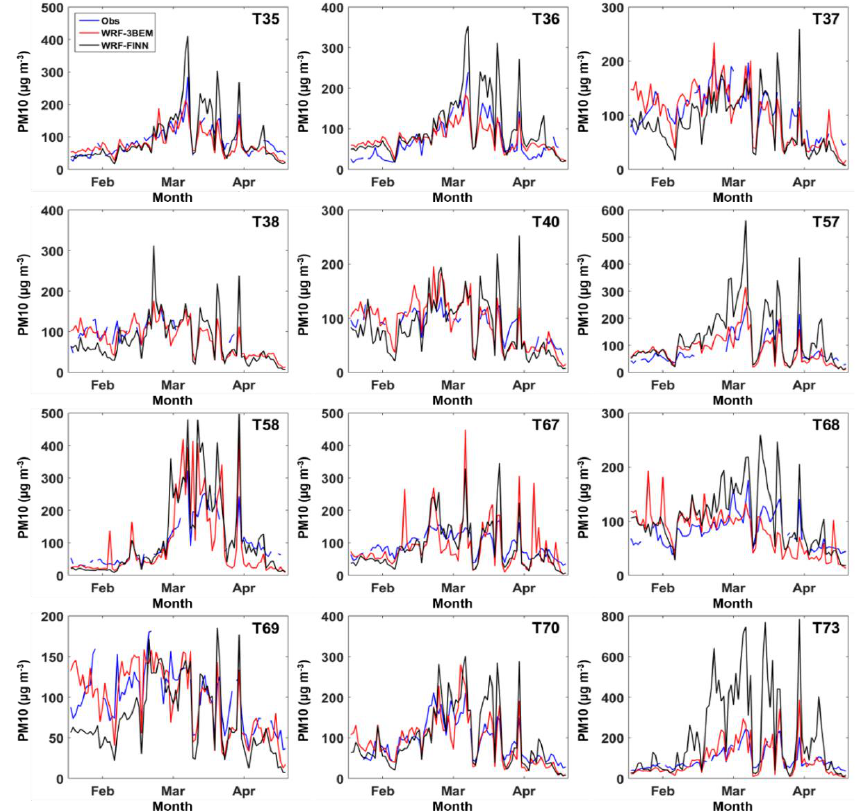
Figure 8. Comparisons of time series of measured daily average PM10 concentrations ( µ g m − 3 ) and simulations of WRF-3BEM and WRF-FINN for February–April in 2014 for 12 ground stations.